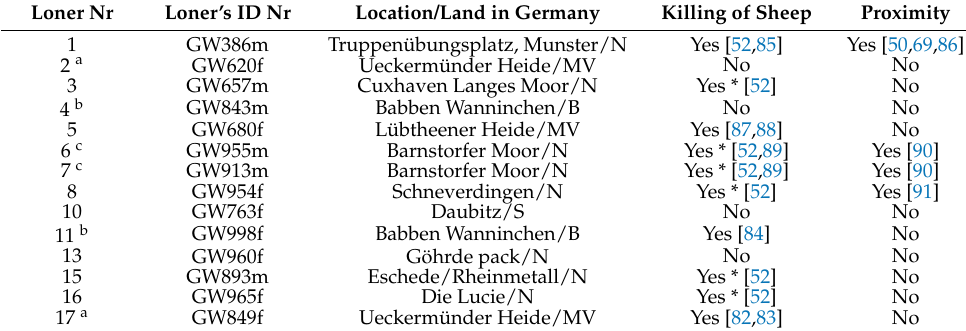
Table 3. Fourteen identified loners that were genetically linked to a parent pack, with their ID number, and references to their parent pack regarding location (N: Niedersachsen; MV: Mecklenburg- Vorpommern; B: Brandenburg; S: Sachsen), killing of sheep and proximity to humans in the period May of the loner’s birth year (or possible birth years) to March of the next year. Loner Nr Loner’s ID Nr